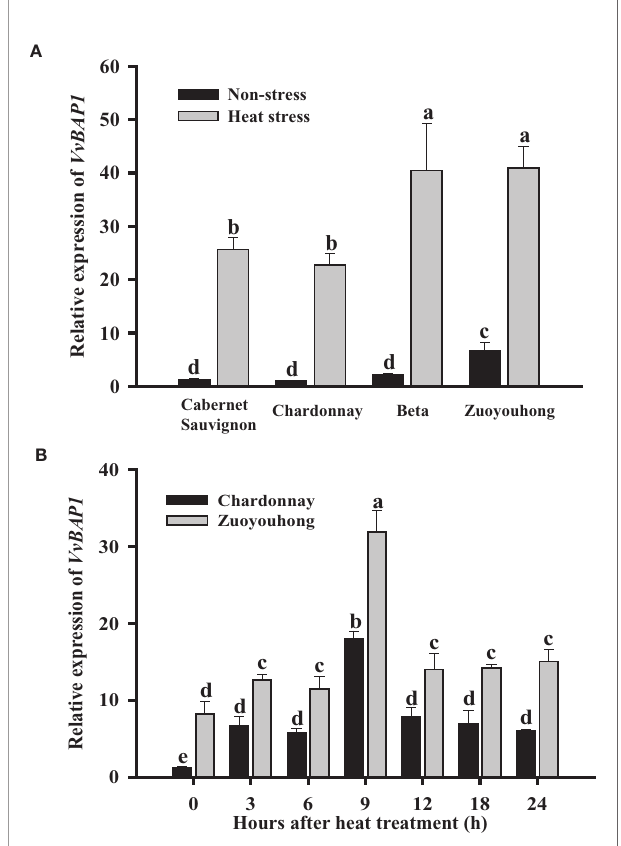
FIGURE 1 | Expressionpro fi lesof VvBAP1 . (A) Relativetranscriptlevelof VvBAP1 inleaves ofdifferentgrape varieties with40°C treatmentafter 9h. Three independentexperimentalreplicationswereconducted.Values arethemeans± SE ofthreeindependentexperiments ( P <0.05). (B) Expressionof VvBAP1 inthe sensitivegrapevinecultivars ‘ Chardonnay ’ andtheresistantvarieties ‘ Zuoyouhong ’ with40°C treatment.Threeindependentexperimentalreplicationswereconducted. Values arethemeans± SE ofthreeindependentexperiments ( P <0.05). Lower- caselettersabovebarsdenotesigni fi cantdifferencesattestedbyTukey ’